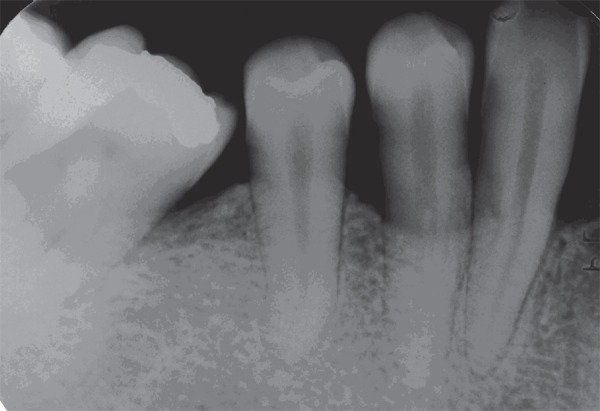
Six-month postoperative radiograph